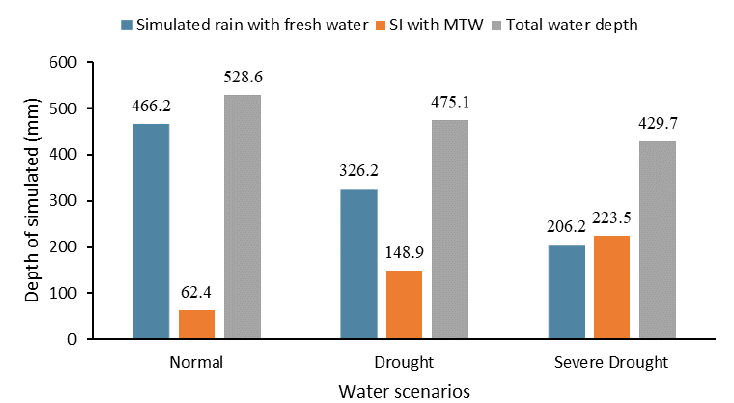
Figure 2. Water depth of simulated rain with freshwater, with supplemental irrigation with municipal treated wastewater (SI with MTW), and the total water depth applied during the cotton cycle. At 80 days after sowing, the stage that begins with the formation of cotton bolls, the shoots’ dry mass and leaf gas exchange parameters were evaluated. Measurements of stomatal conductance (gs, mol m − 2 s − 1 ) and photosynthesis rate ( A , µ mol m − 2 s − 1 ) were performed using a portable Infrared Gas Analyzer (model LI-6400XT, LI-COR, Lincoln, NE, USA), with a light intensity of 1800 µ mol m − 2 s − 1 . The readings were taken in the morning, between 08:00 and 10:00 a.m., on fully expanded leaves of each plant under ambient conditions of temperature and relative